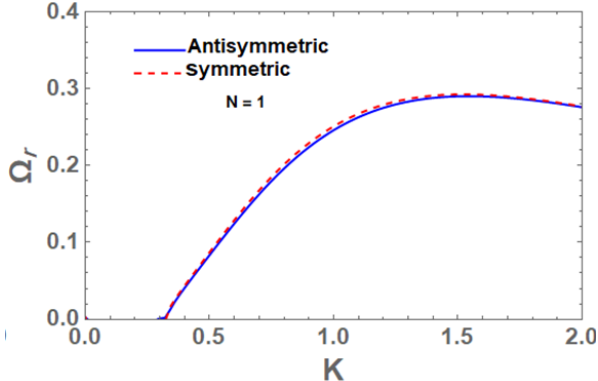
Figure 15. Variational of non-dimensional Ω r with non-dimensional K in three-dimensional case ( N = 1 ) for both anlisymmetric and symmetric disturbances with the same values of the parameters shown before.